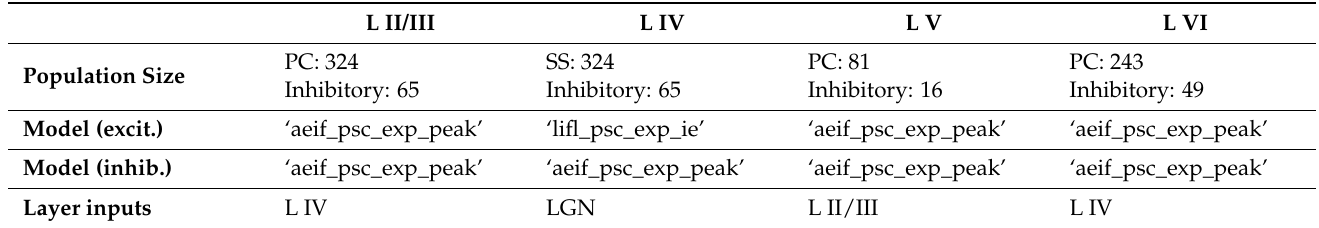
Table 2. Network size and neuron types of the computational model implemented. The term layer is here abbreviated with L .